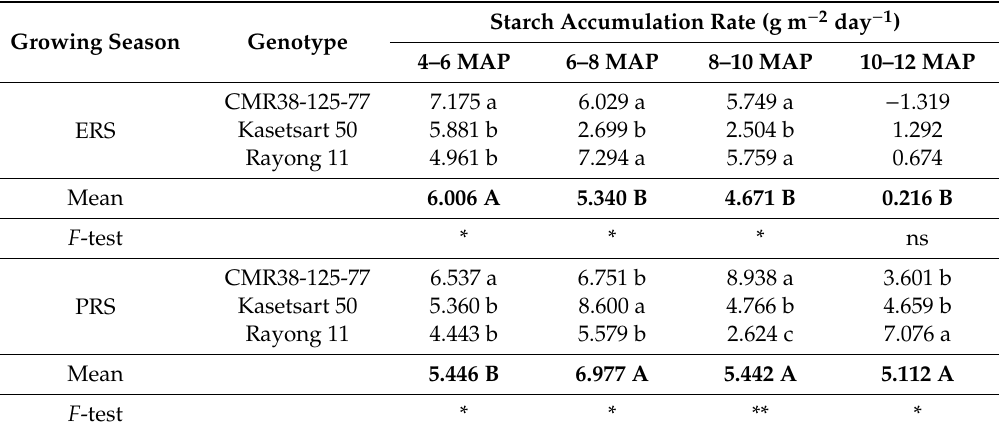
three cassava genotypes grown in early rainy seasons (ERS) and post rainy seasons